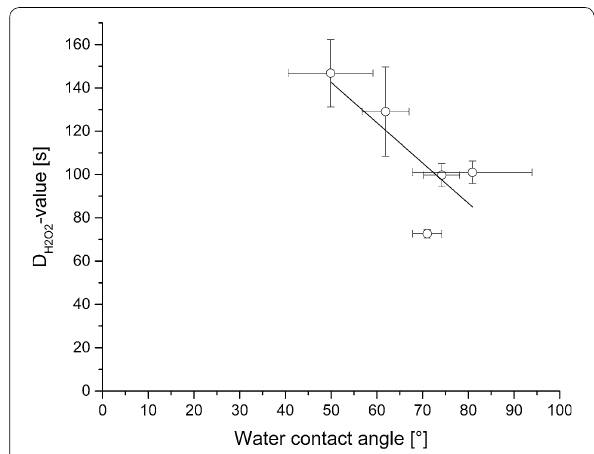
Fig. 3 Log linear inactivation trends of the spores cultivated at differ- ent pH values ( filled square pH 7.00, filled circle pH 7.50, filled triangle pH 8.00, open triangle pH 8.50, open square pH 9.00)